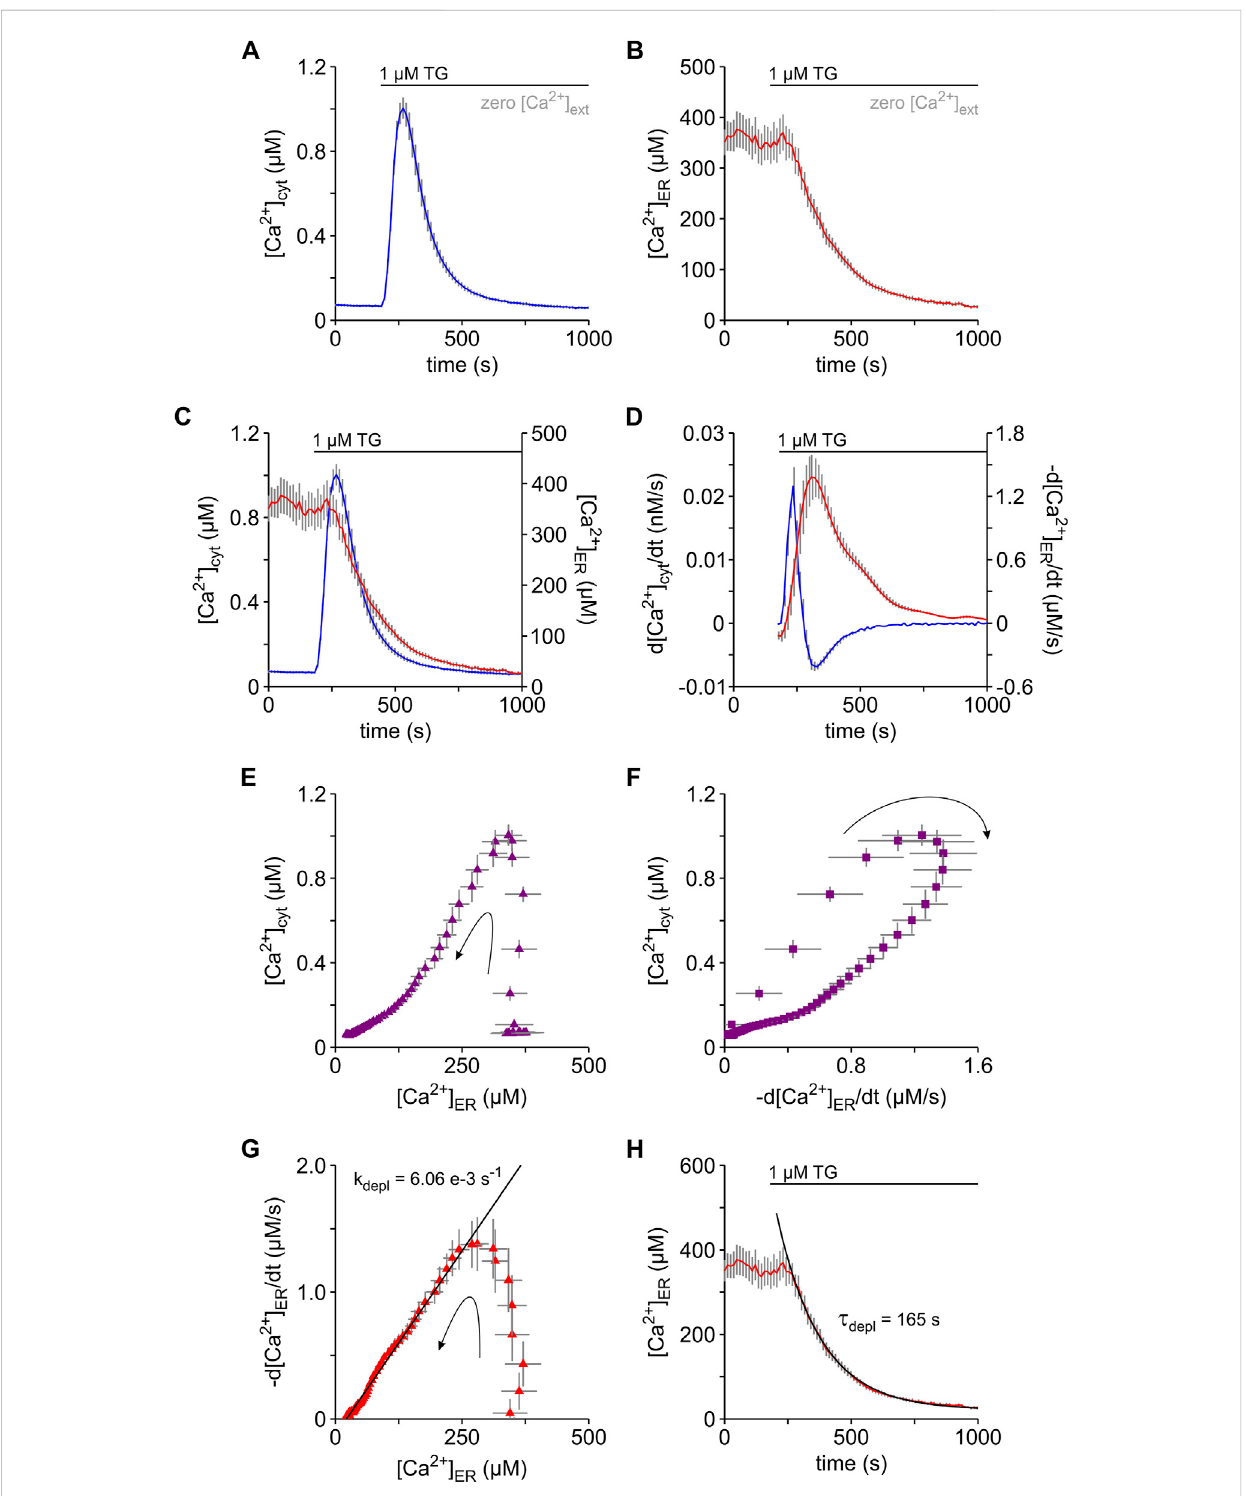
FIGURE 3 Analysis of the Ca 2+ depletion in the ER and its impact on cytosolic Ca 2+ levels of HEK-D1ER cells. Simultaneous imaging of cytosolic Ca 2+ ([Ca 2+ ] cyt ) andERCa 2+ ([Ca 2+ ] ER )wereperformedwithFURA-2andD1ER inthesamecells, respectively. Forthispurpose, weused theHEK-D1ERcell linethat stably expresses the genetically encoded ER Ca 2+ sensor D1ER. To prevent entry of external Ca 2+ , the experiments were carried out in the absence of external Ca 2+ (zero [Ca 2+ ] ext ). (A – C) Thapsigargin (1 μ M TG) induced a surge in [Ca 2+ ] cyt (A) that timely correlated with a decrease in [Ca 2+ ] ER (B) . [Ca 2+ ] cyt and [Ca 2+ ] ER are superimposed to illustrate the correlation (C) . (D) Temporal changes of cytosolic and ER Ca 2+ are shown as the fi rst derivatives of [Ca 2+ ] cyt (d[Ca 2+ ] cyt /dt, blue) and [Ca 2+ ] ER (-d[Ca 2+ ] ER /dt, red), respectively. (E,F) The dependence of [Ca 2+ ] cyt on [Ca 2+ ] ER (E) and -d[Ca 2+ ] ER /dt (F) strengthens the impactoftheCa 2+ leakfromERoncytosolicCa 2+ . (G,H) Thedecayingphaseintheplotofd[Ca 2+ ] ER /dtvs.[Ca 2+ ] ER followsalinearrelationasexpectedfor a fi rst order kinetic with a constant leak rate (k depl ) of 6.06 e − 3 s − 1 (G) . Accordingly, an exponential function with a time constant ( τ depl ) of 165 s, which re fl ects the invers of k depl , best fi ts the time course of the TG-induced decay of [Ca 2+ ] ER (F) . Protocols of TG application are depicted above the graphs. Arrows indicate the time course of events (E – G) . Data is given as mean ± SEM. Number of cells: